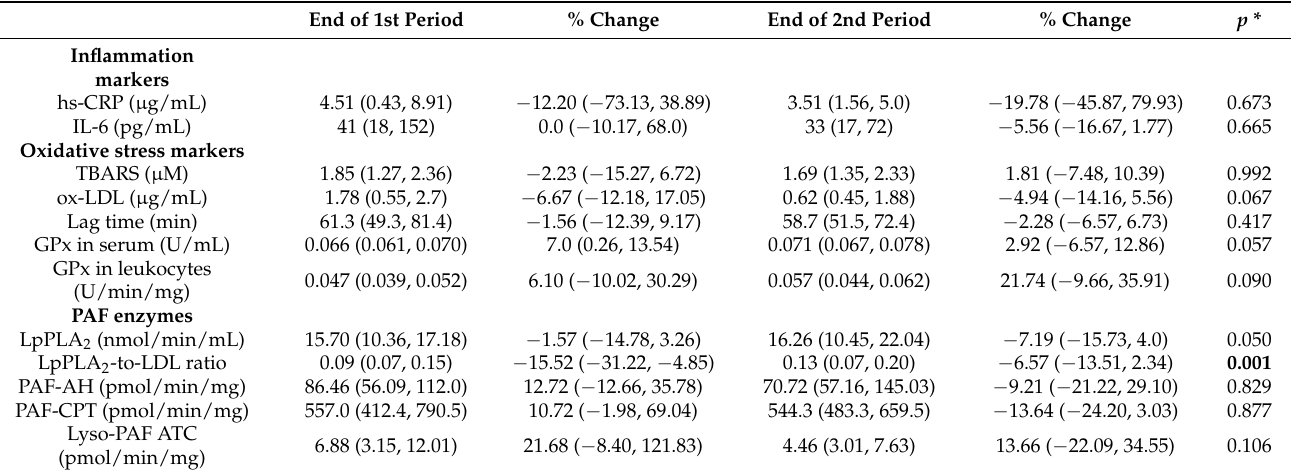
Table 3. Inflammation markers, oxidative stress markers, and enzymes of PAF metabolism of the participants on the enriched fish (EF) diet by period.